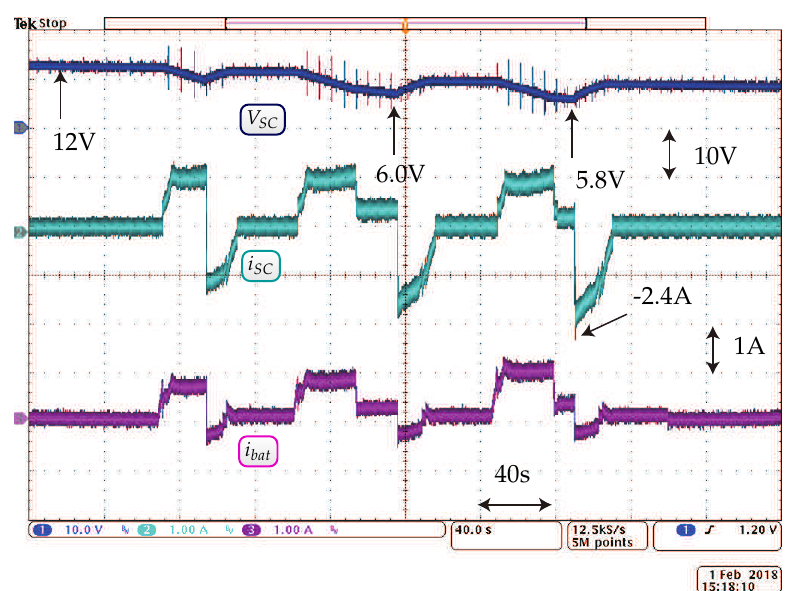
Figure 13. Experimental results for the proposed sliding forward window optimization EMS with three typical stops in the driving cycle of the LR: SC current, SC voltage, and battery